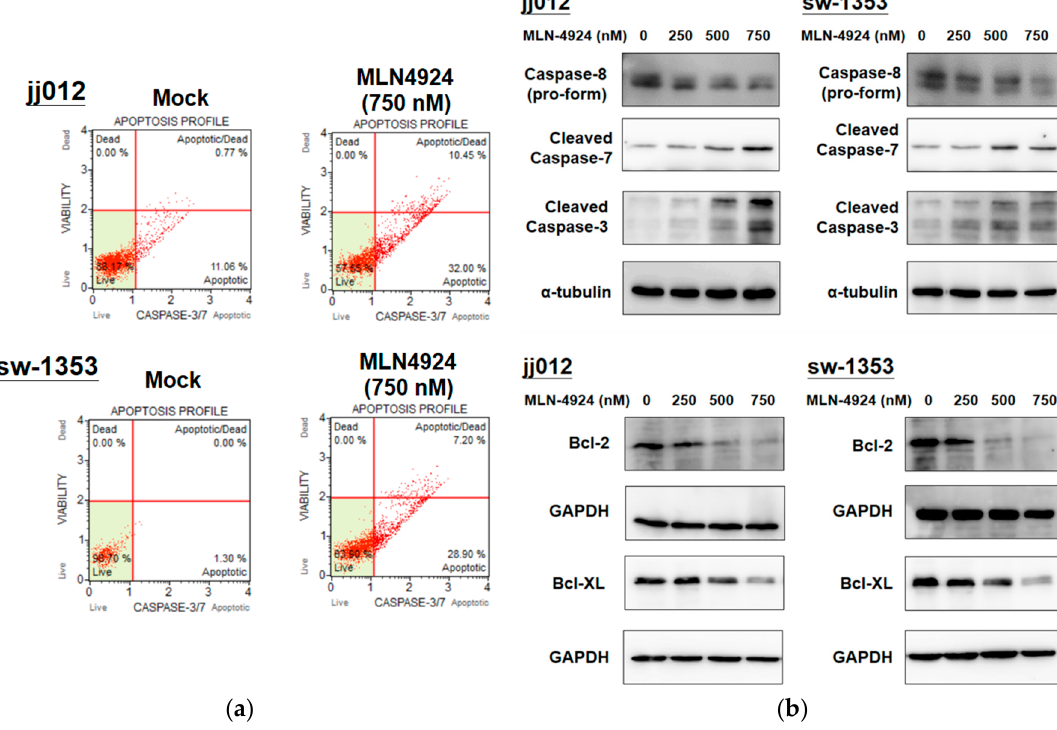
Figure 3. MLN4924 induced apoptosis through caspase-3/7 activation in human chondrosarcoma cell lines. ( a ) The jj012 and sw-1353 cells were treated with 750 nM MLN4924 and DMSO (for the nontreated control group) for 48 h. The activation of caspase-3/7 on apoptotic cells was analyzed using fluorescence-activated cell-sorting flow cytometry. ( b ) After they were harvested, total cell lysates were analyzed by conducting a Western blot analysis that used specifically cleaved caspase-3/-7, casepase-8 (pro-form), Bcl-2, and Bcl-XL antibodies. Similar results were obtained in at least three independent experiments.